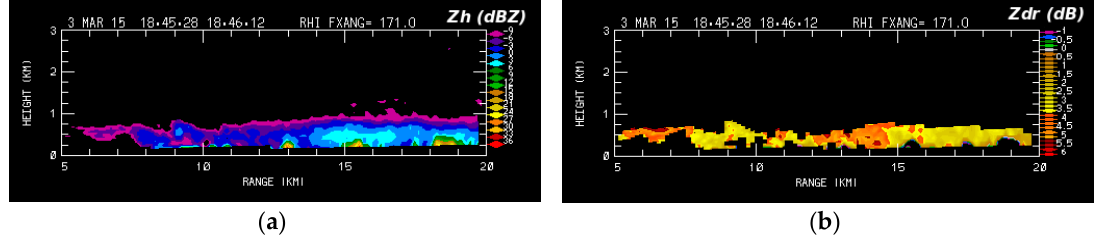
MASCRAD Easton site at 18:45 UTC on 3 March 2015.